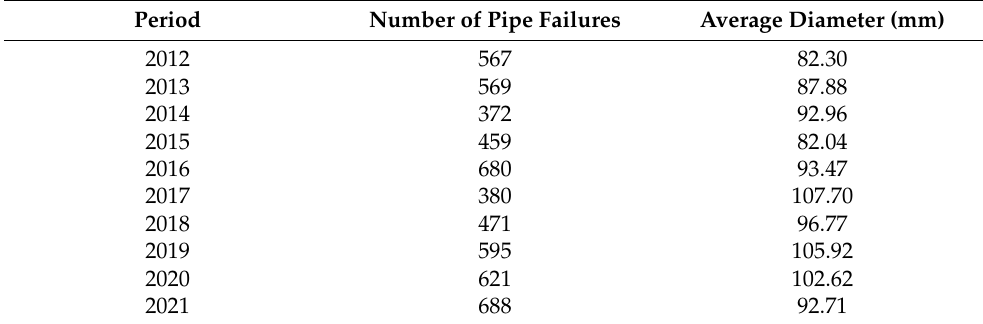
Table 2. Annual pipe failures of PVC